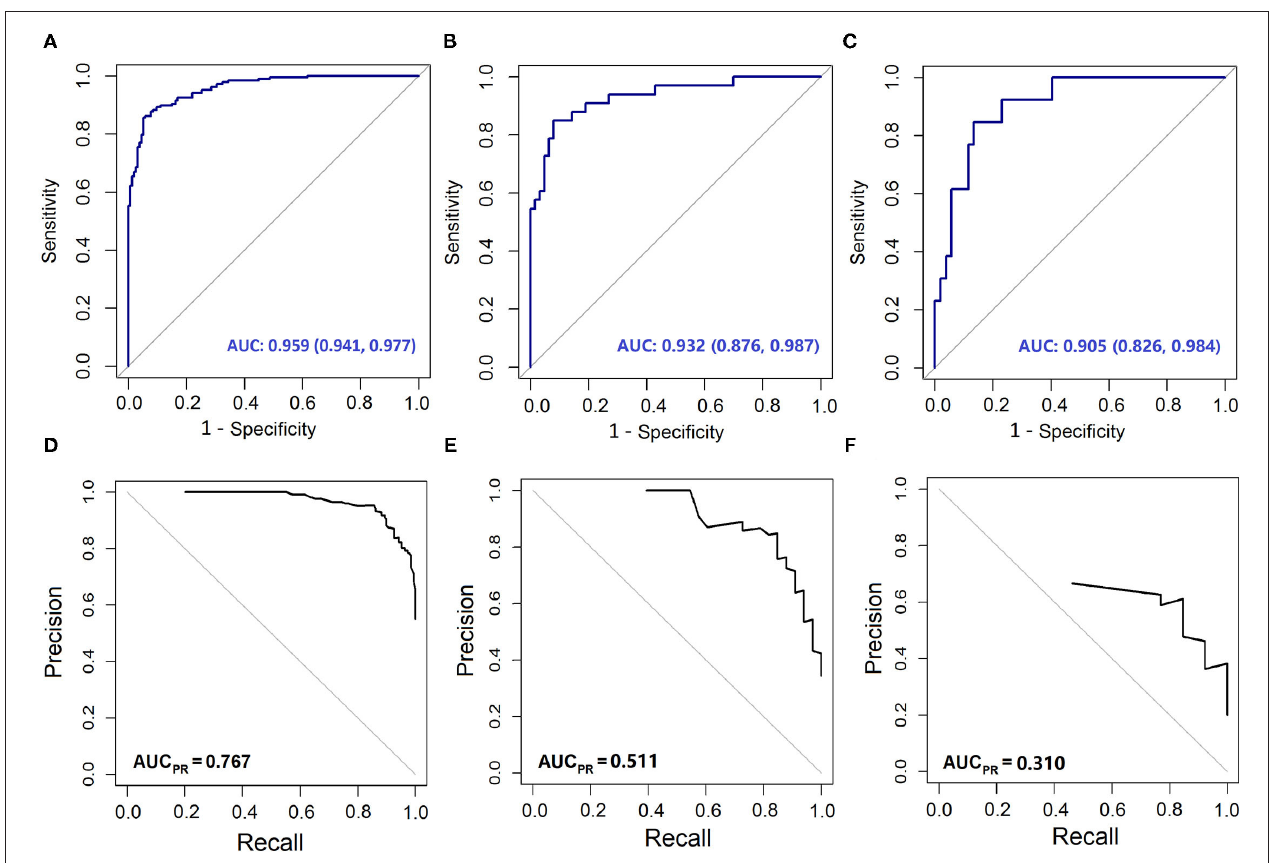
FIGURE 2 | The Area Under the receiver operating characteristic Curve (AUC) and Precision-Recall (PR) curves of different models. The AUC curves of (A) development set; (B) validation cohort 1; (C) validation cohort 2. The PR curve of (D) development set; (E) validation cohort 1; (F) validation cohort 2.